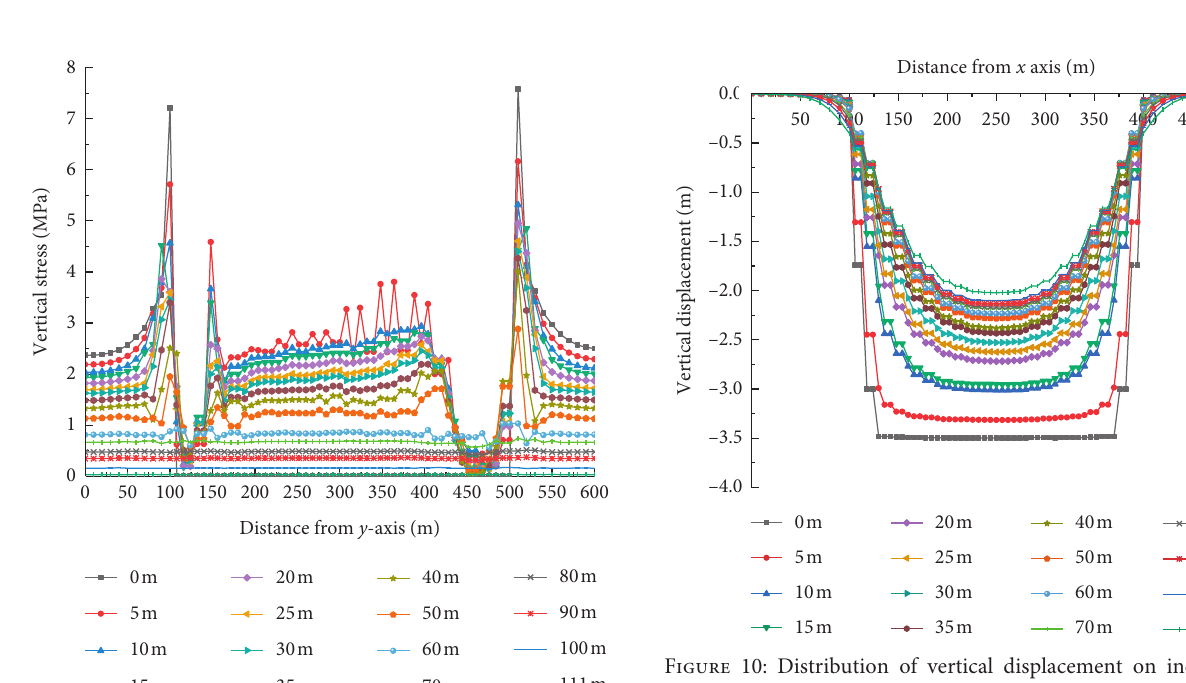
Figure 8: Layer dislocation phenomenon. (a) Field measurement [29]. (b) Similar simulation [30].